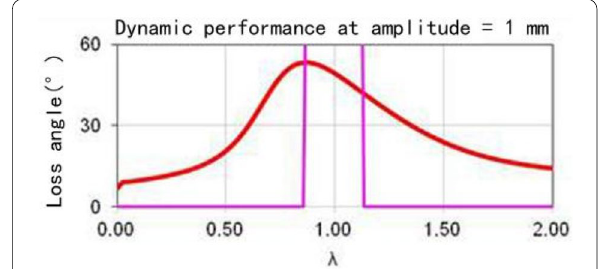
Figure 4 Loss angle dimensionless simulation curve